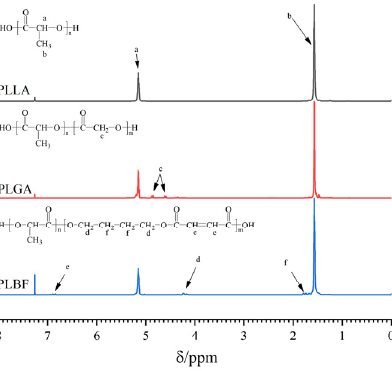
Figure 2. 1 H NMR spectra of PLLA, PLGA, and PLBF.